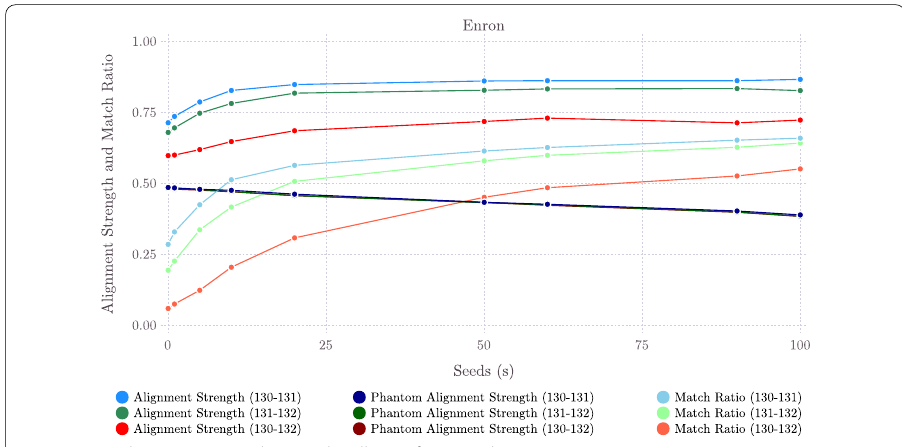
Fig. 10 Matching Enron email networks; all pairs from weeks { 130,131,132